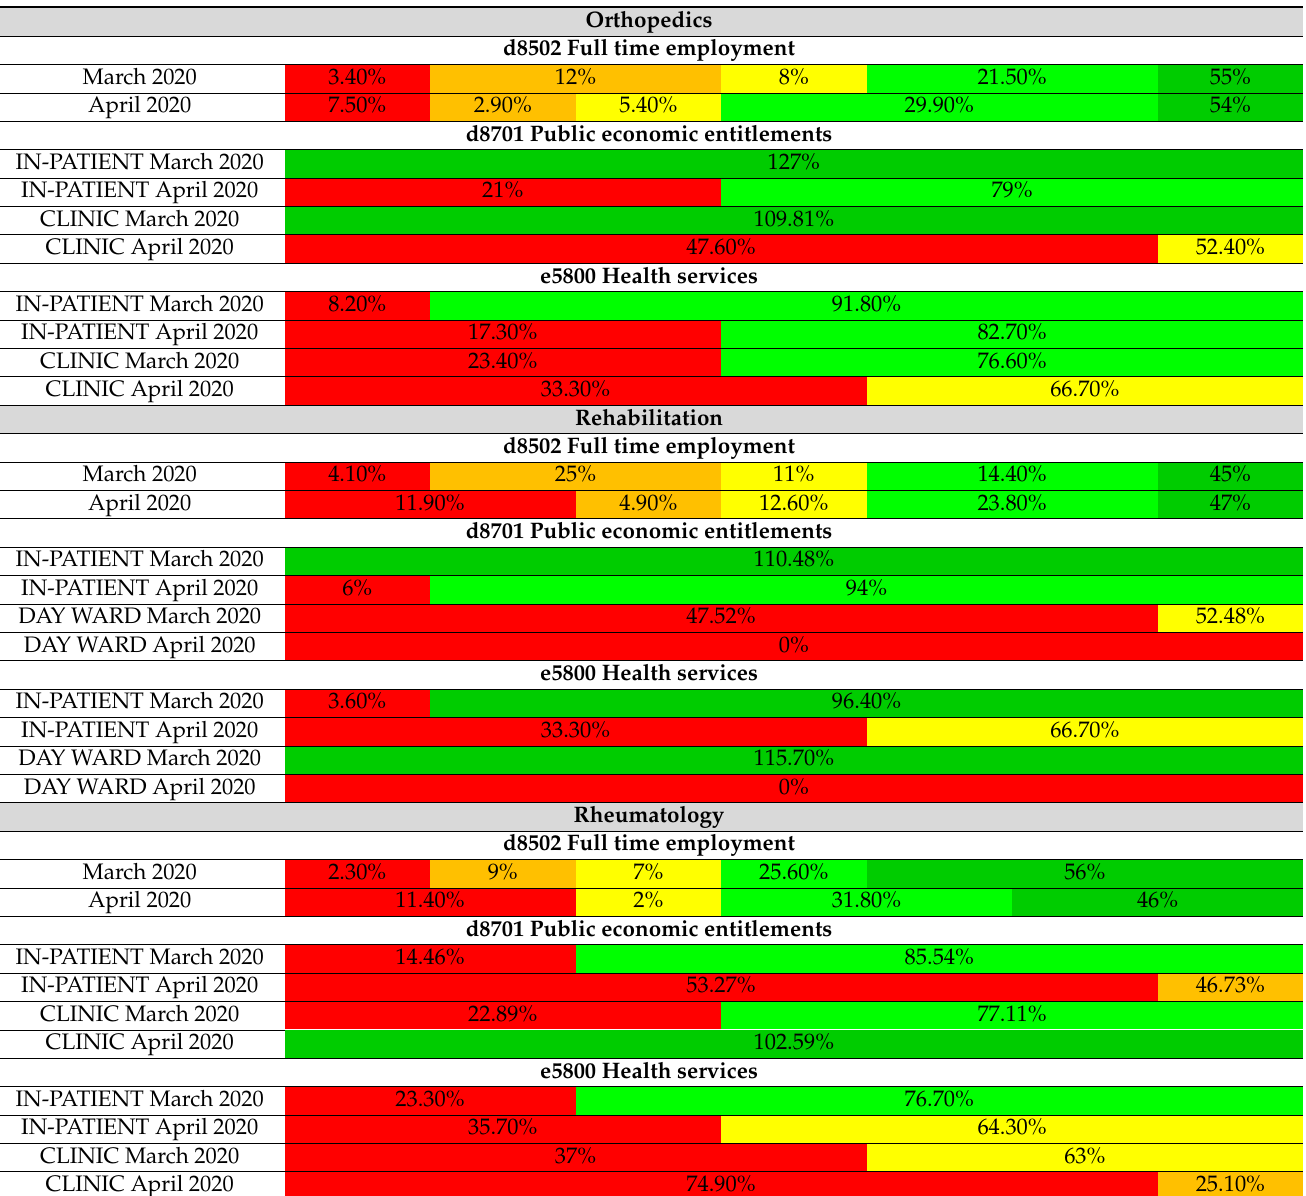
Table 2. Percentage distribution of the evaluated International Classification of Functioning, Disability and Health (ICF) qualifiers by treatment